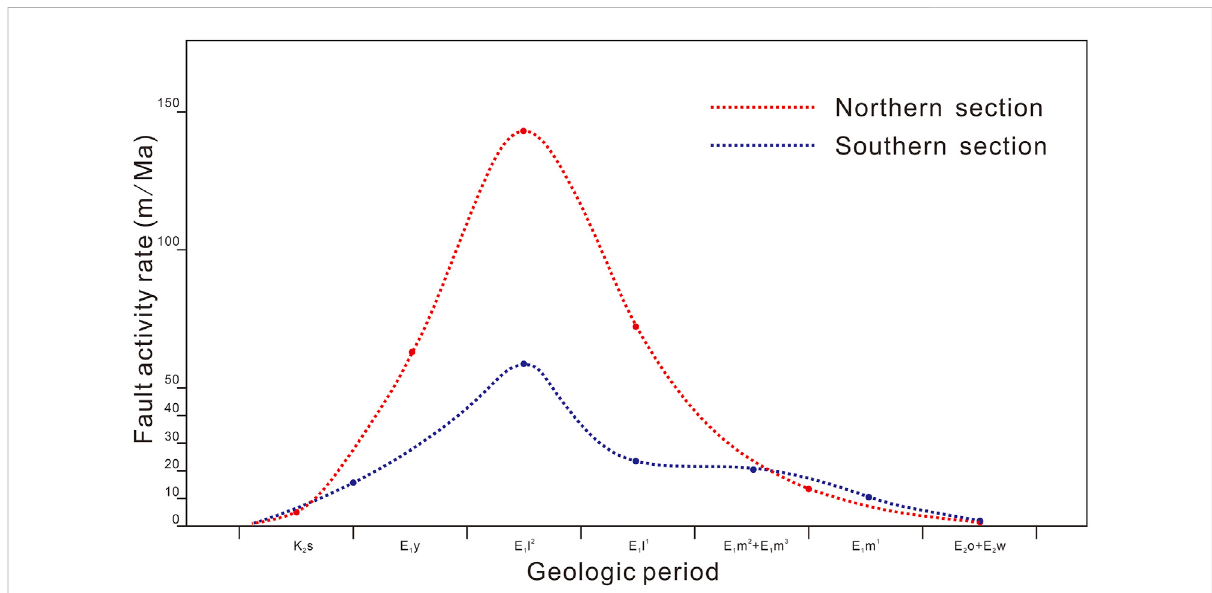
FIGURE 6 RMS V of main boundary faults of northern and southern sections in the Lishui West Sag.